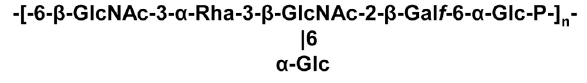
FIGURE 2 | Structure of sugar-phosphate polysaccharide pellicle of L. lactis